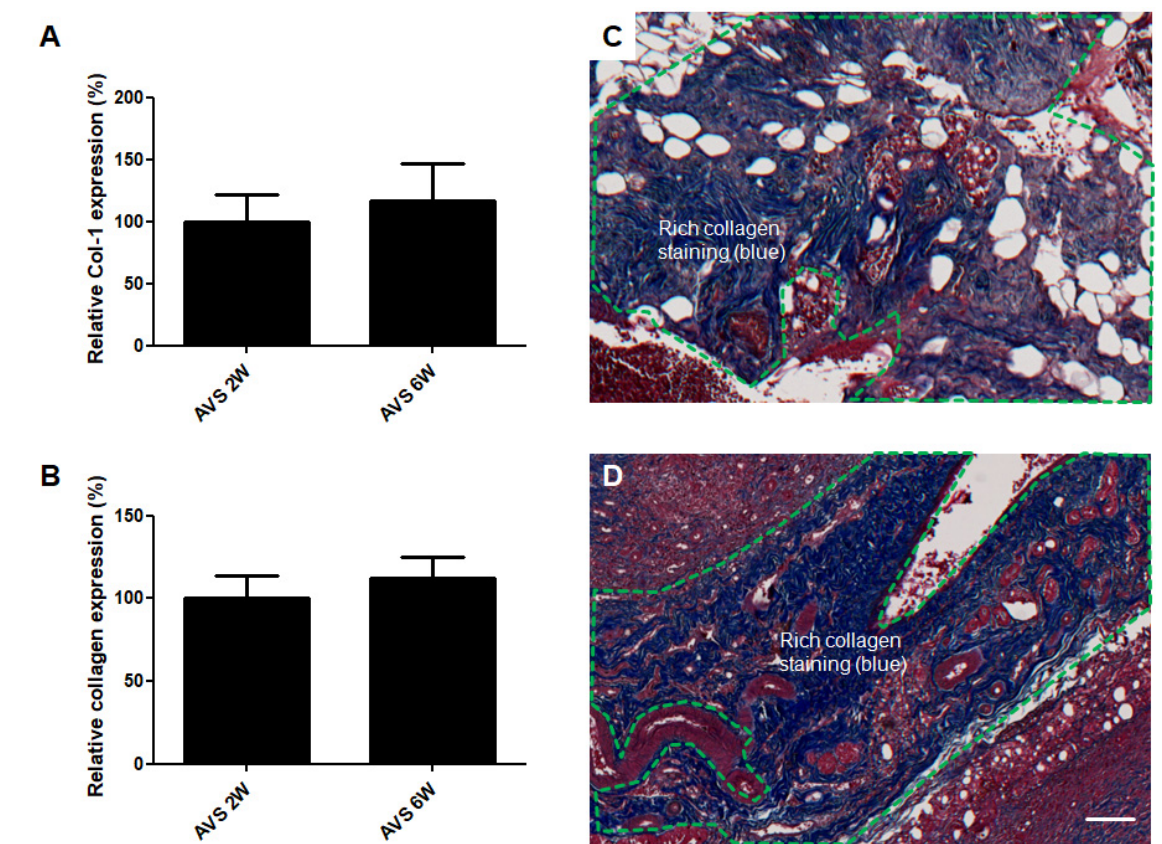
Figure 6. Collagen deposition of AVS-vascularized mSVF explants after two and six weeks. ( A ) No difference in collagen 1 α 1 mRNA levels was observed in mSVF explants after two and six weeks. ( B ) Next, trichrome staining was performed to visualize collagen expression in AVS-vascularized mSVF explants after two and six weeks. Statistical analysis revealed no difference in collagen deposition. Representative trichrome stainings of vascularized mSVF after ( C ) 2 weeks and ( D ) 6 weeks are depicted. The green dotted line demonstrates similar blue collagen staining after two and six weeks. Bar: 100 µm.